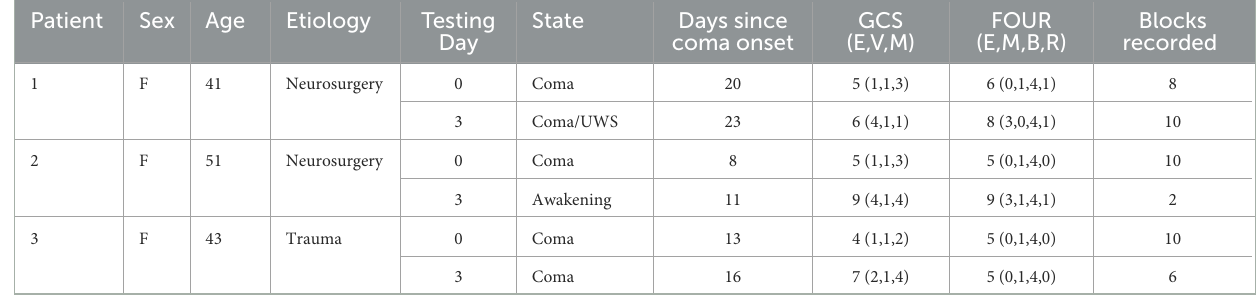
TABLE 1 Patient demographics and clinical